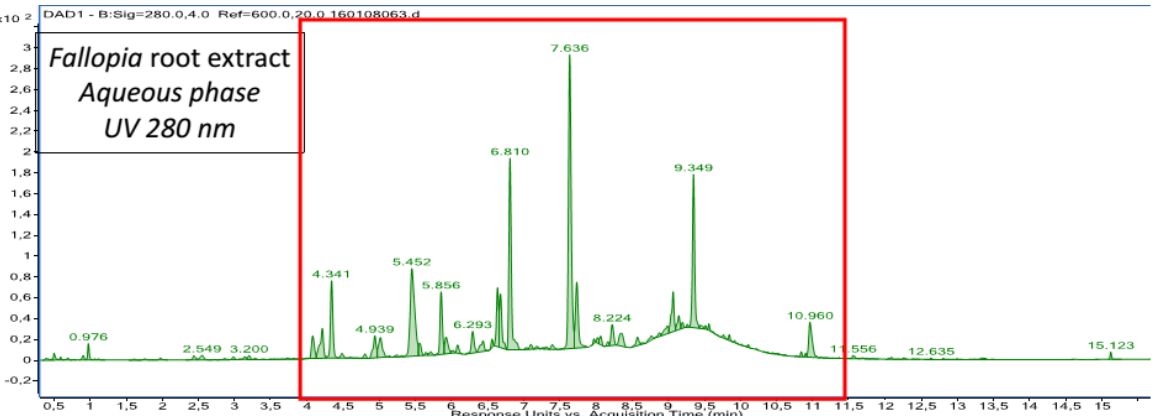
Figure A5. UHPLC chromatogram with UV detector at 280 nm of F. japonica roots aqueous frac- tion.